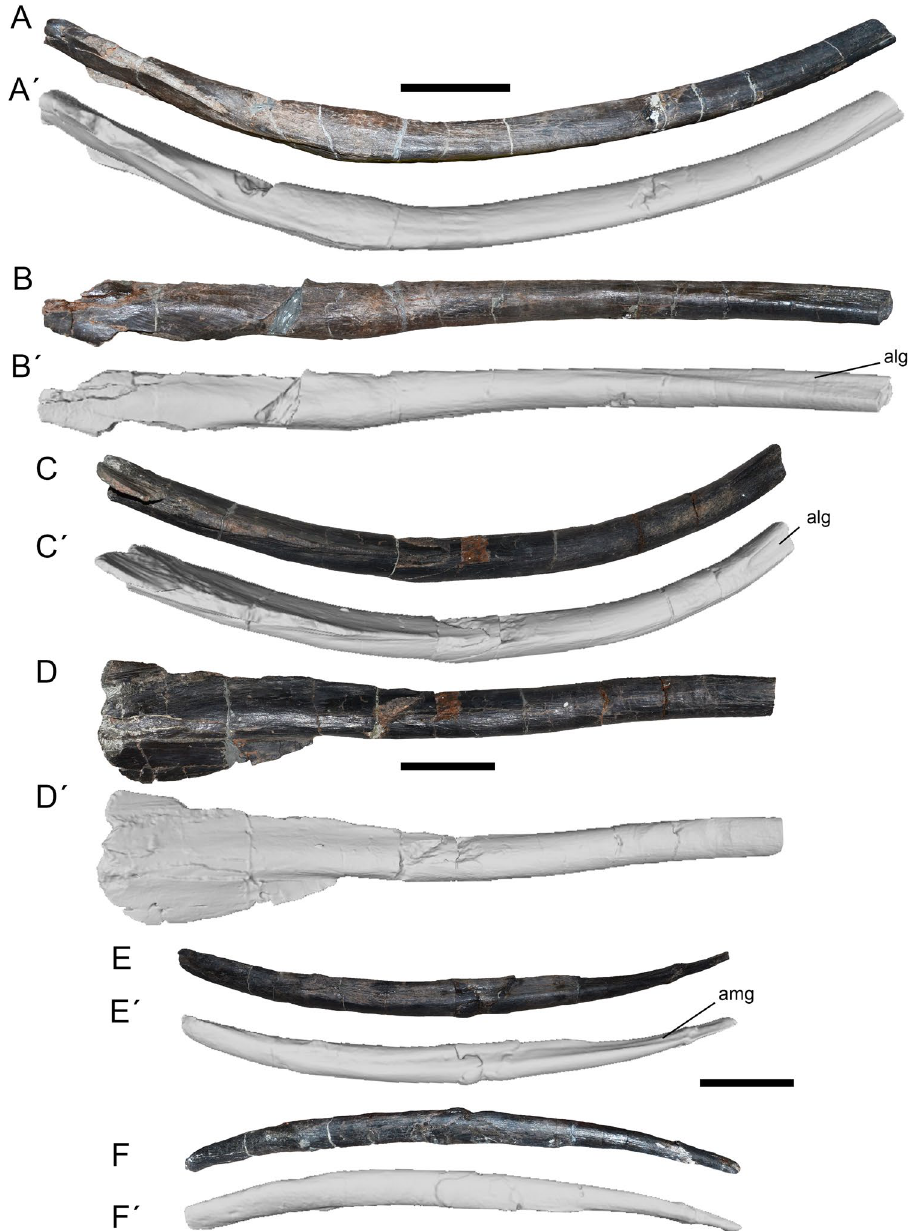
Figure 12. Medial ( A – D ) and lateral ( E – F ) gastral elements of Maip in anterior ( A , C , E ) and dorsal ( B , D , F ) views. Scale bar: 5 cm. Abbreviations: alg, articulation surface for lateral gastralia; amg, articulation surface for medial